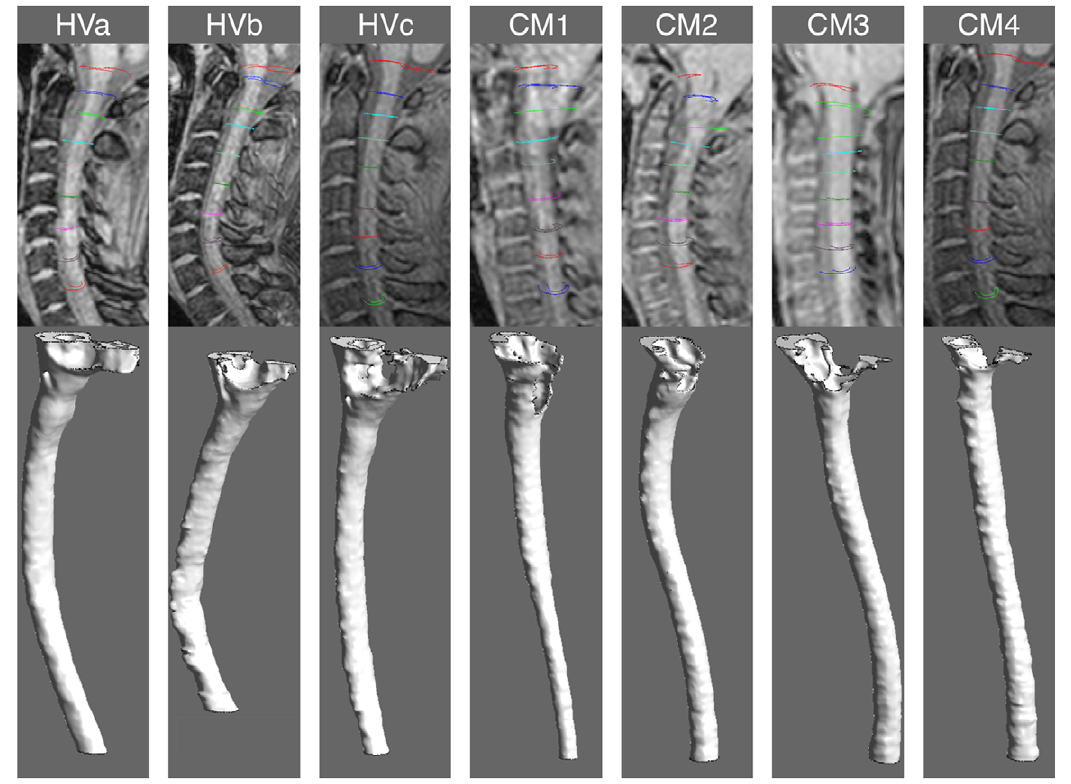
Figure 2. 3D reconstruction of the cervical SSS based on manual segmentation. Segmentation of the healthy subjects (left) and CM patients (right). The 3D reconstruction depicts the SSS where the CSF pulsates (between the dura and spinal cord tissue). Note the SSS constriction near the FM in the four CM patients in comparison to the healthy subjects.